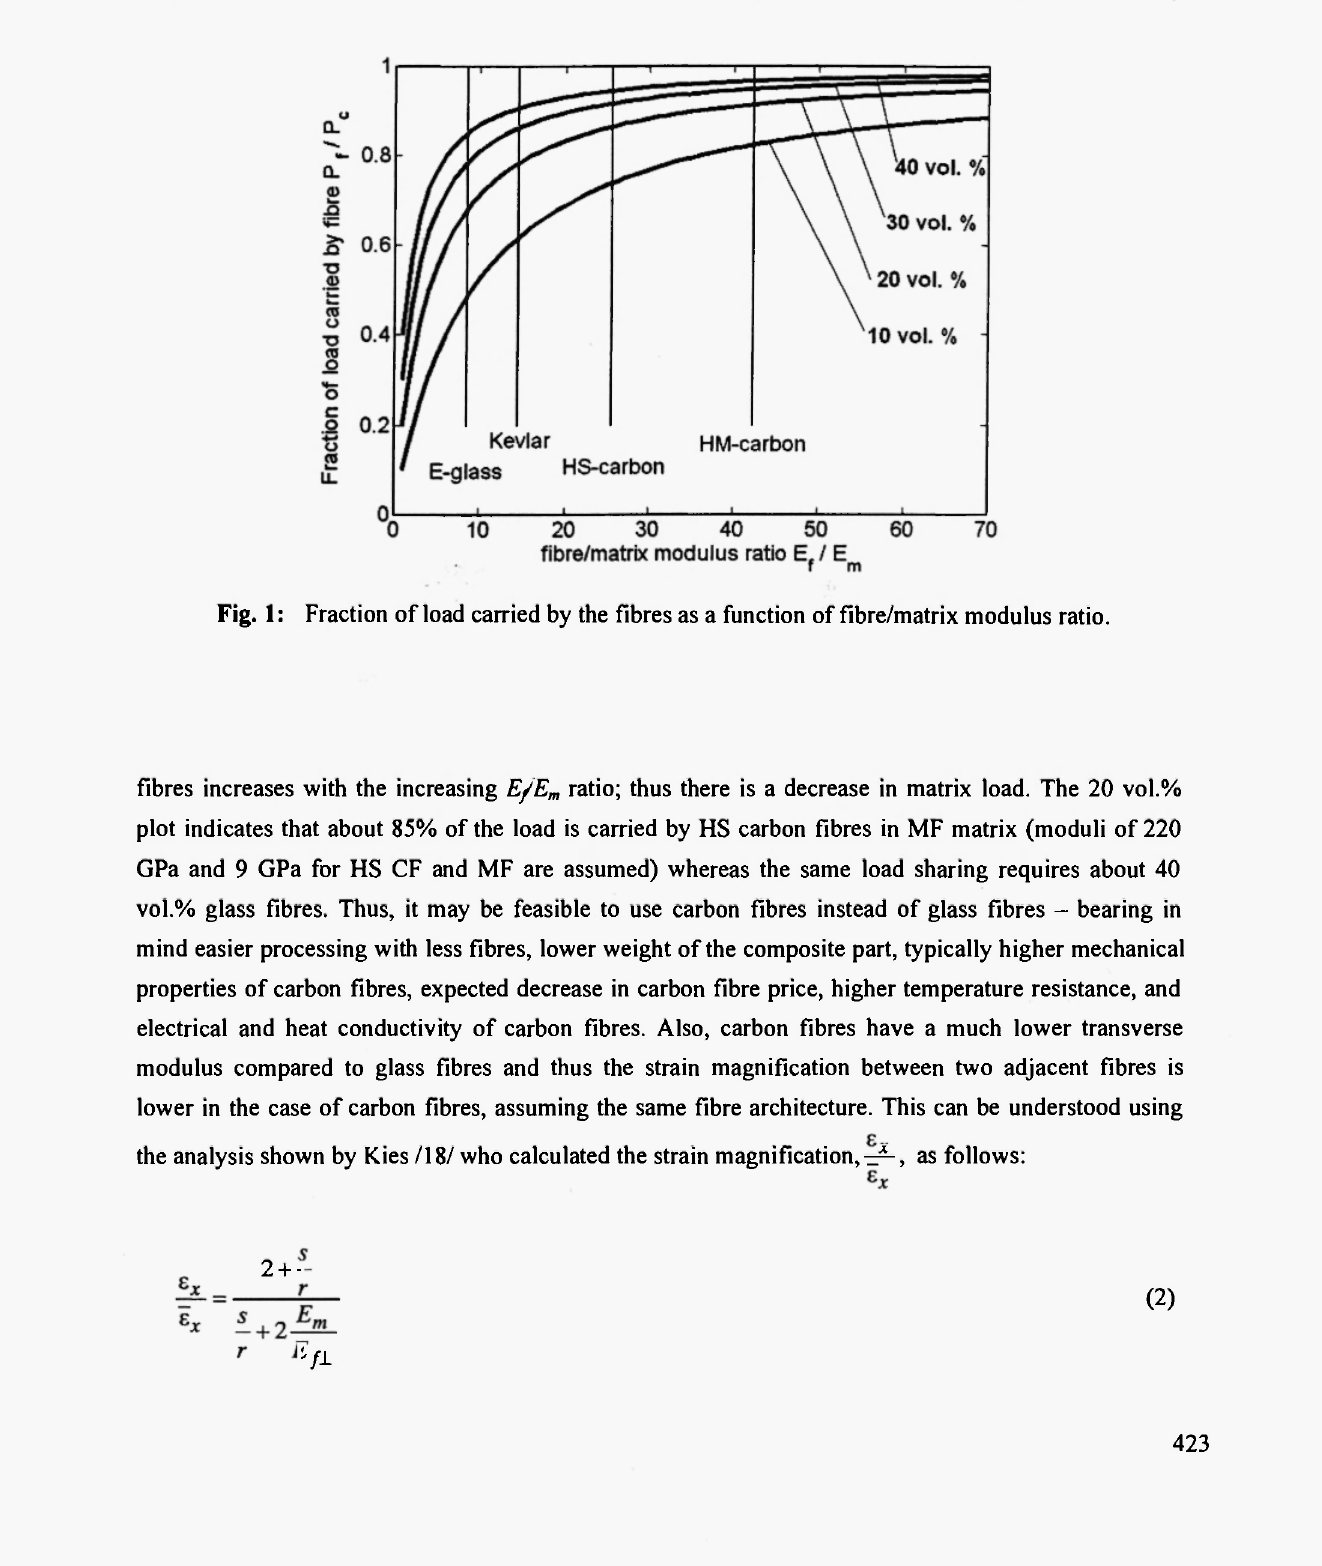
Fig. 1: Fraction of load carried by the fibres as a function of fibre/matrix modulus ratio.